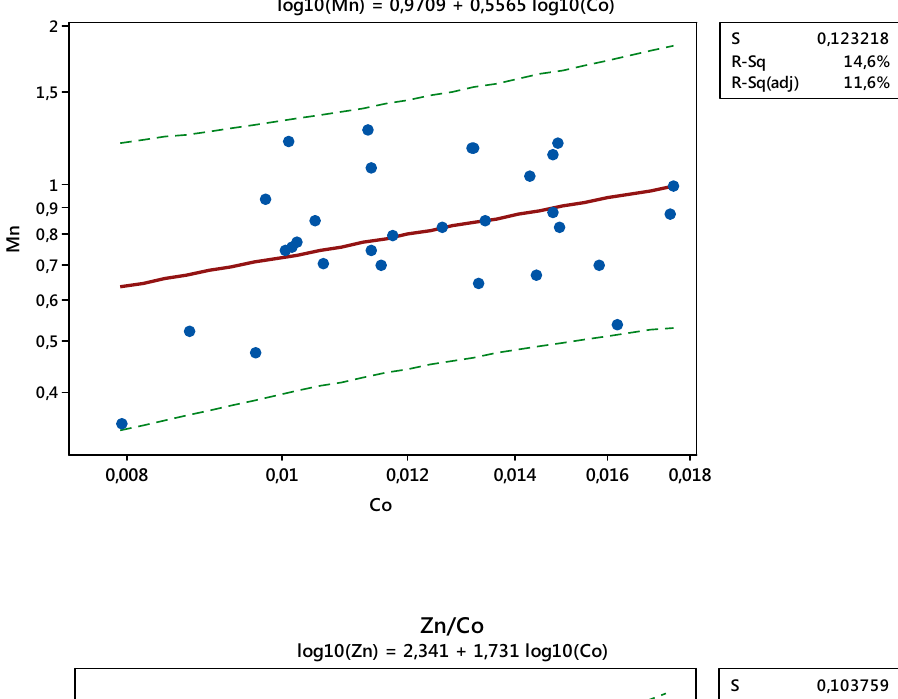
Fig. 9 Linear regression graph of zinc background concentra- tion determination ( R 2 =